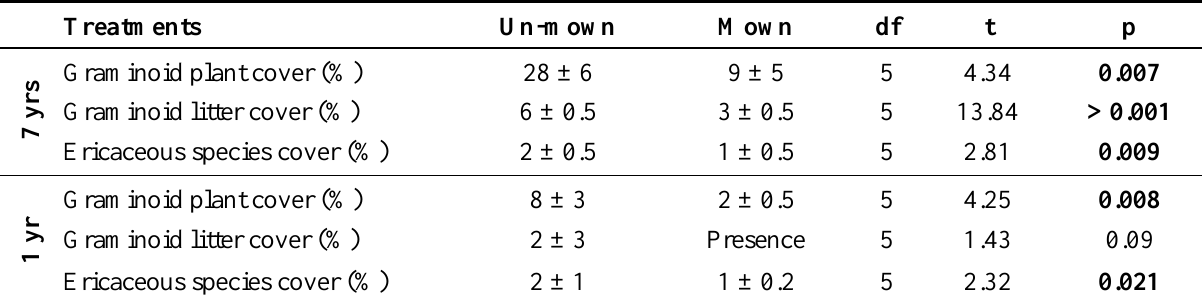
Table 2. Mean cover of graminoid plants, graminoid litter and ericaceous species ± CI (95 %) after three years of mowing for un-mown and mown treatments. Significant differences are shown in bold type (p-value < 0.05) (Paired t-test 1 , α =